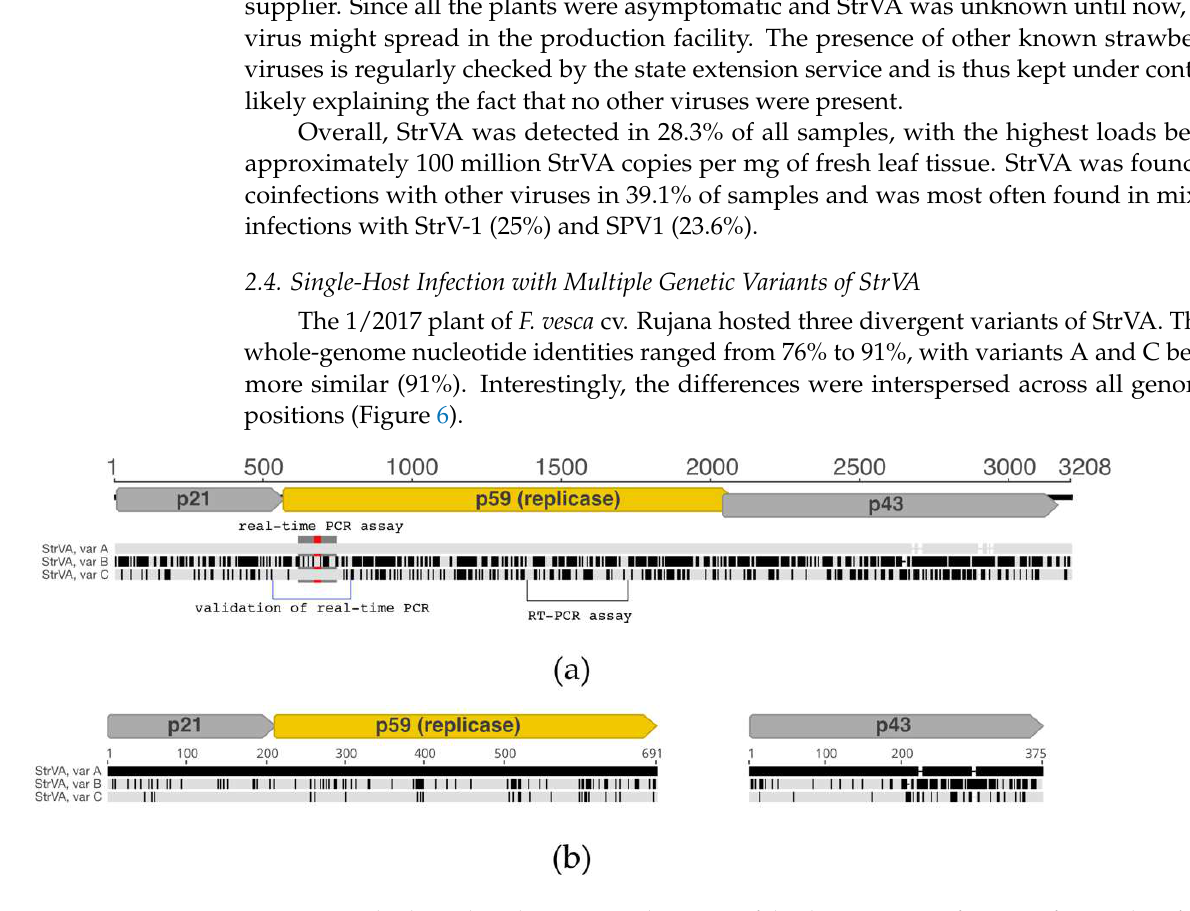
Figure 6. Multiple nucleotide sequence alignment of the three variants of StrVA infecting the 1/2017 strawberry plant. StrVA, var. A was selected as the reference; all differences from the reference are in black. ( a ) Alignment of nucleotide sequences of complete genomes. Regions used for the estimation of StrVA variability and validation of qPCR and RT-PCR assays are annotated. ( b ) Alignments of amino acid sequences of p21+p59 and p43 proteins.